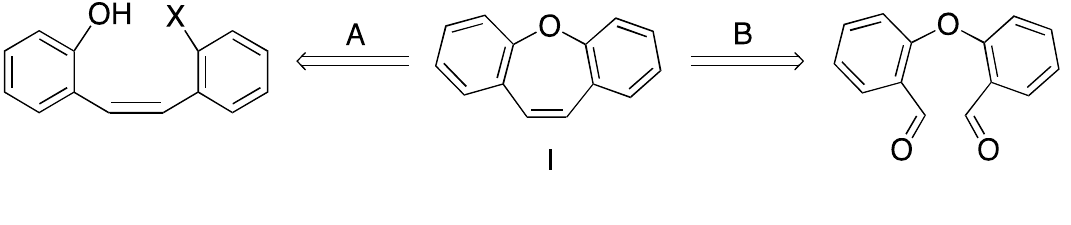
Scheme 1. Strategies for the synthesis of dibenzo[ b , f ]oxepin